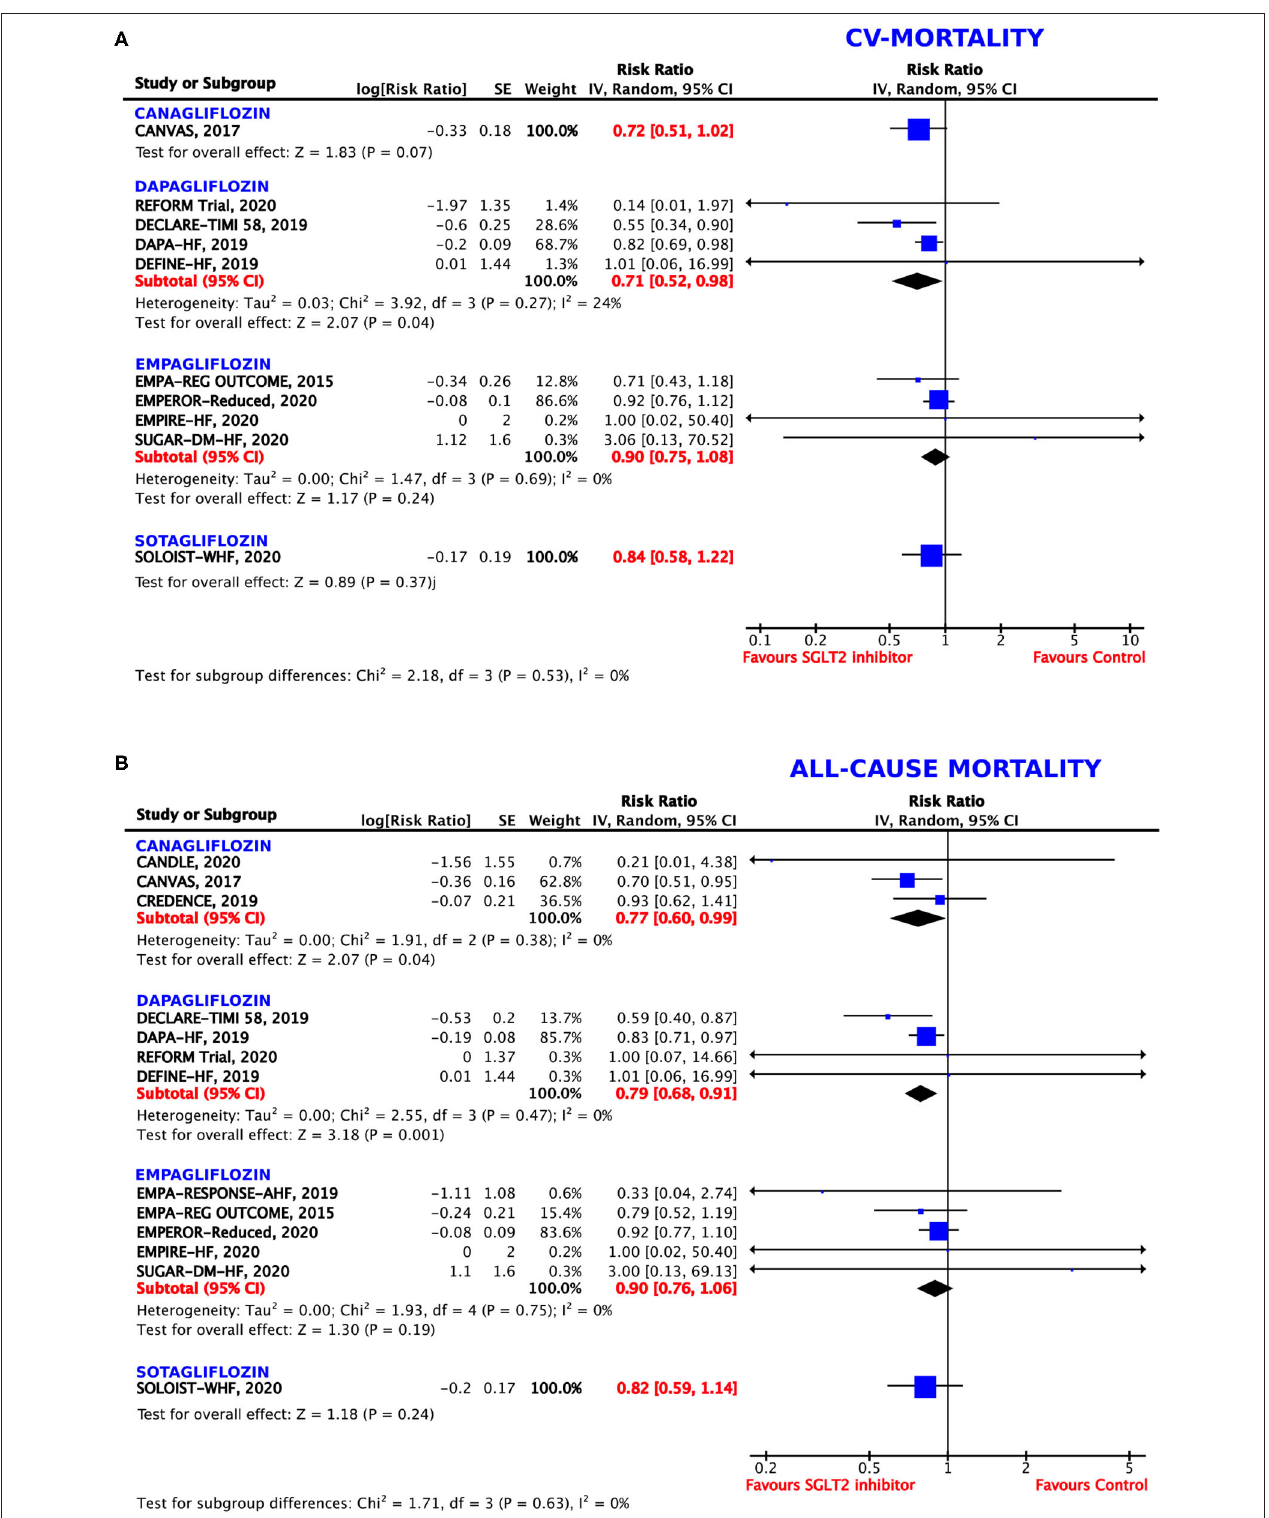
FIGURE 4 | Forest plot depicting the relative risk (RR) according to the administered type of SGLT2 inhibitor for (A) cardiovascular (CV) mortality alone and (B) all-cause mortality.